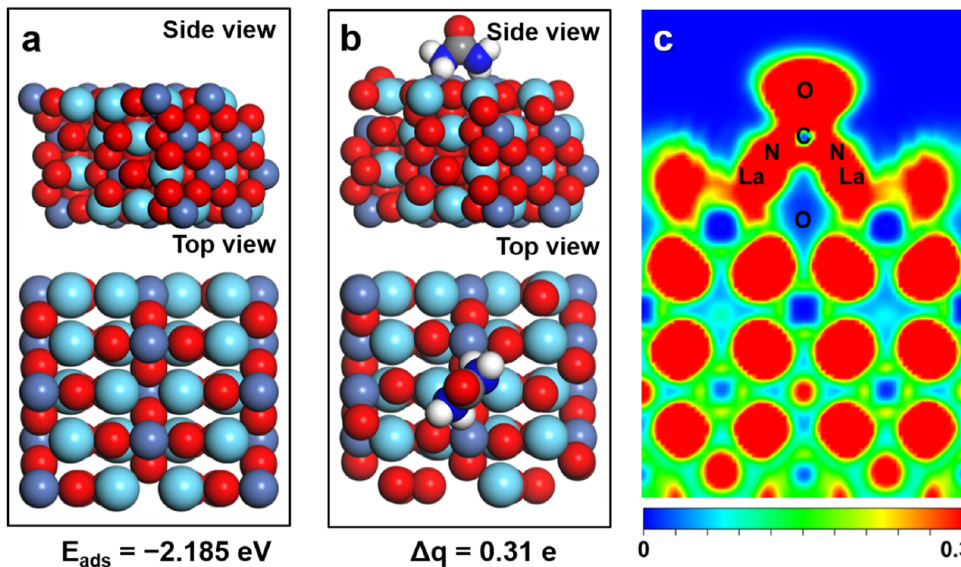
Figure 5. Optimization structures of ( a ) La 2 NiO 4 and ( b ) urea molecules adsorbed on La 2 NiO 4 , and urea adsorption energies and Bader charges. ( c ) Electron location function (ELF) for urea molecules adsorbed on La 2 NiO 4 . The green, navy blue, red, gray, blue, and white spheres represent La, Ni, O, C, N, and H atoms, respectively.